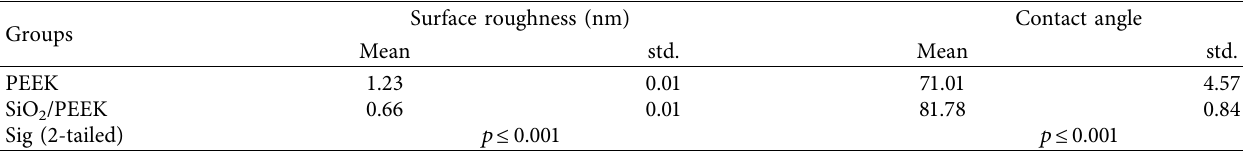
Table 2: Mean values and standard deviation for surface roughness and contact angle data of pure PEEK and SiO